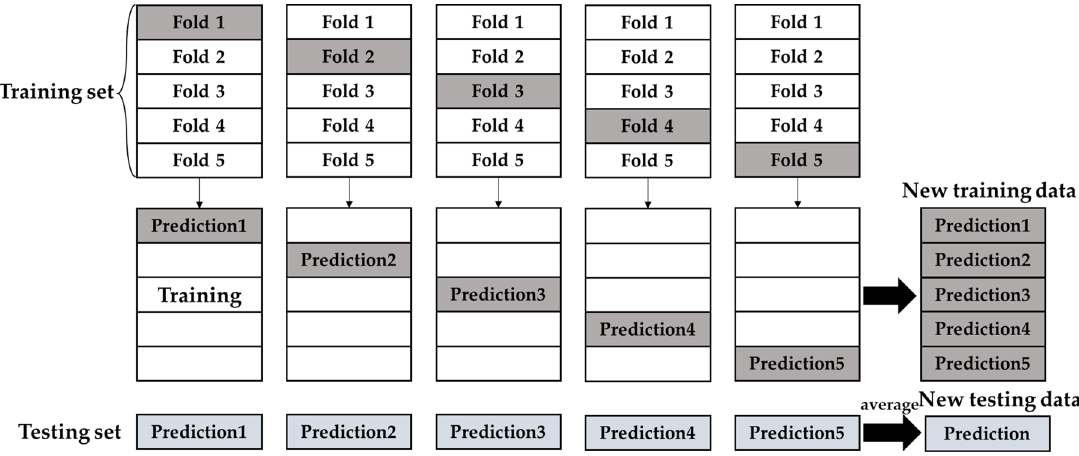
Figure 1. Diagram of the k -fold cross validation.